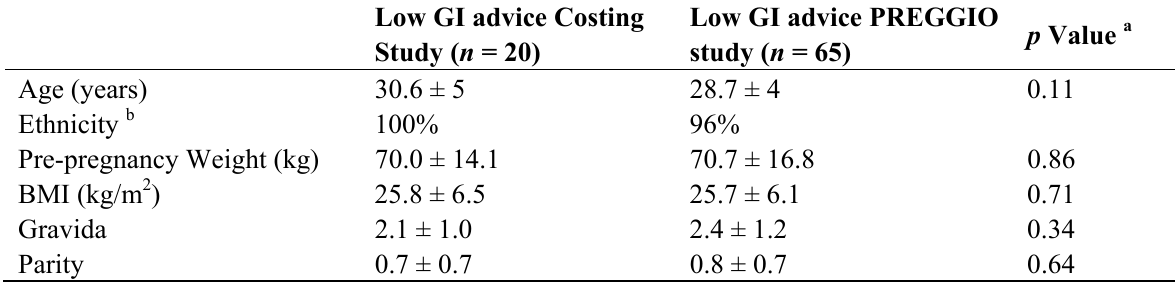
Table 1. Characteristics of women in the low Glycaemic Index (GI) cost diet ( n = 20) versus those in the Pregnancy and Glycaemic Index Outcomes (PREGGIO) study ( n = 65).